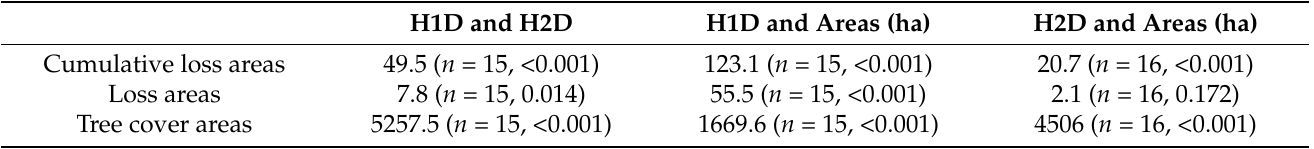
Table 3. F-values and corresponding degrees of freedom and p -values in brackets for linear regressions between Higuchi dimensions 1D and 2D and between Higuchi dimensions and corresponding